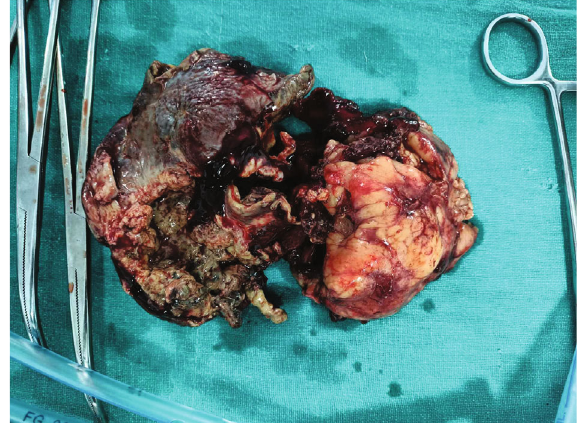
Figure 3: Gross specimen of the gangrenous spleen after